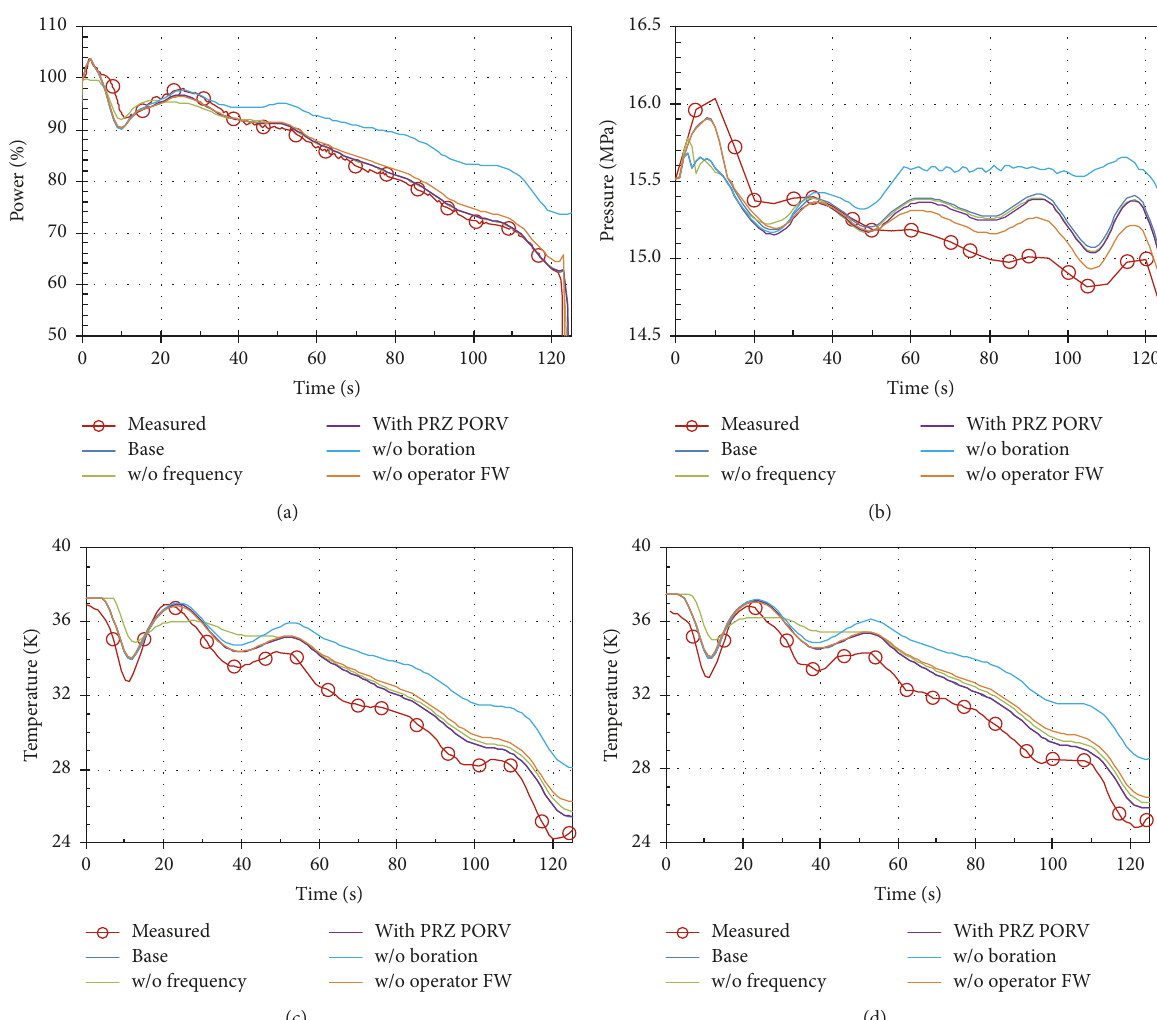
Figure 8: First part: (a) reactor power; (b) pressurizer pressure; (c) delta temperature number 1; (d) delta temperature number